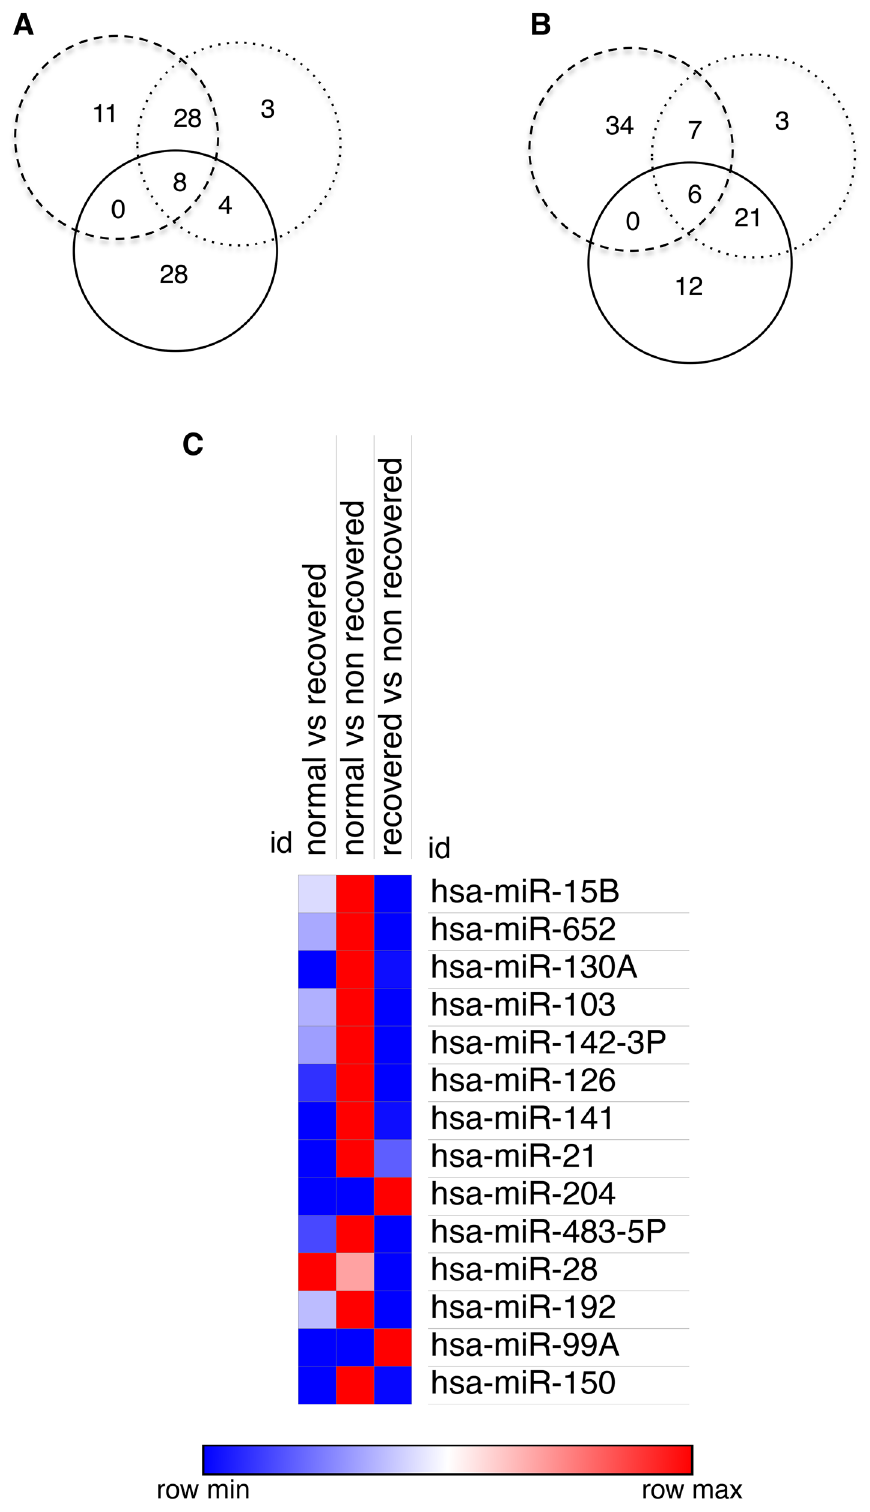
Figure 1. Comparison of expression profiles of 377 urinary miRNAs in pooled urine samples from recovered and nonrecovered AKI patients. ( A , B ) Using TaqMan Low Density Array (TLDA) Human microRNA Card A with global normalisation, urinary miRNAs from recovered AKI patients (n = 6), nonrecovered AKI patients (n = 5) and control subjects (n = 20) 11 were analysed. Venn diagrams depicting miRNAs with ≥ twofold increased ( A ) and decreased ( B ) detection when comparing recovered AKI with controls (dashed circle), non-recovered AKI with controls (dotted circle) and non-recovered AKI with recovered AKI (solid circle). ( C ) Heatmap showing changes between recovered, non-recovered and controls with a ≥ twofold change in all three comparisons. The heatmap was generated using Morpheus software from the Broad Institute (Morpheus, https:// softw are. broad insti tute. org/ morph